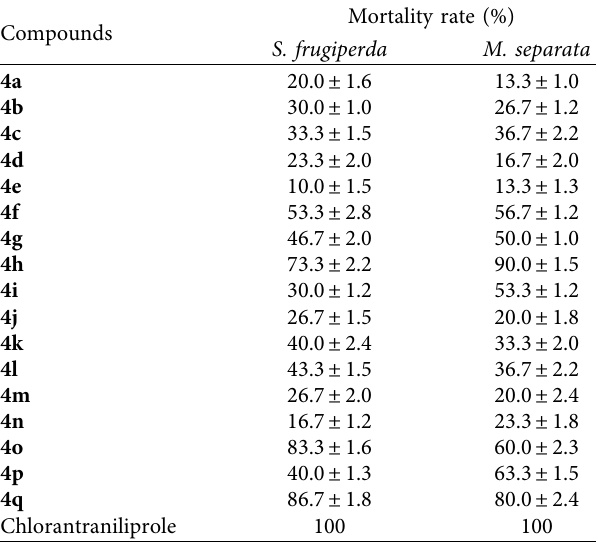
Table 2: The insecticidal activities against S. frugiperda and M. separata of the target compounds 4a – 4q at 500 µ g/mL. Mortality rate (%) Compounds